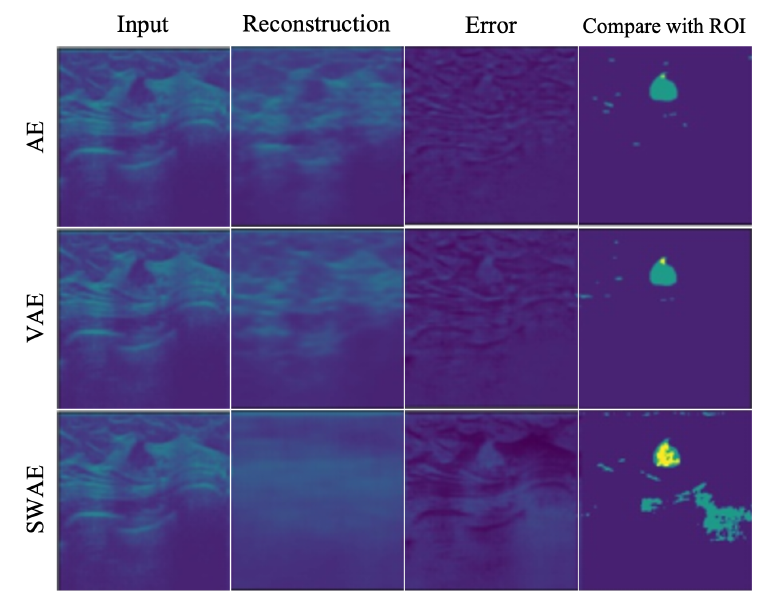
Figure 10. Reconstructed result images by